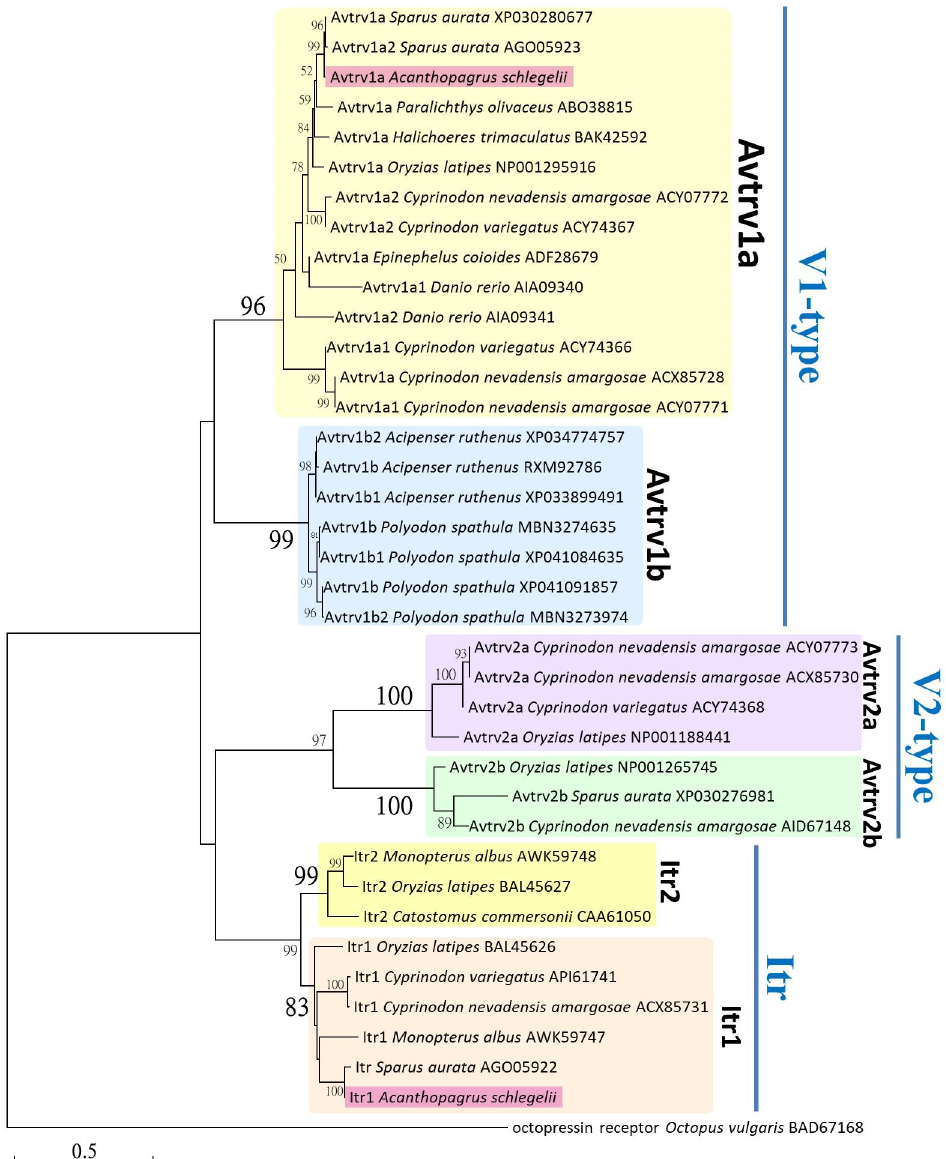
Figure 2. A neighbor-joining (NJ) phylogenetic tree of neurohypophysial hormone receptor amino acids. The phylogenetic tree was constructed based on the alignment of 38 partial amino acid sequences of Avtr and Itr from selected fishes using the neighbor-joining method with pairwise deletion and 1000 bootstrap replicates. The number shown at each branch node indicates the bootstrap value (%); only values and branching above 50% are shown. This tree was rooted using the sequence of octopressin receptor from an octopus and shows major branches of two V1-type receptors (Avtrv1a and Avtrv1b), two V2-type receptors (Avtrv2a and Avtrv2b), and two It receptors (Itr1 and Itr2). The cloned sequences from black porgy were grouped into Avtrv1a and Itr1, and are illustrated. Scientific names of fishes and GenBank accession numbers of sequences are shown in figure.